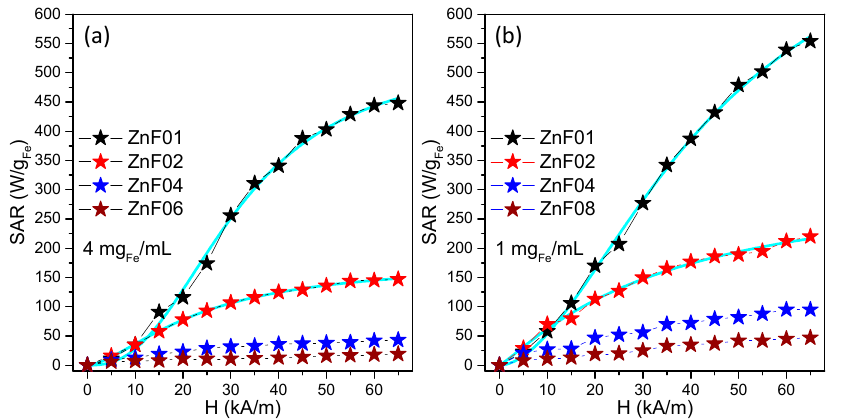
Figure 5. Specific absorption rate (SAR) dependence on the AMF amplitude (H) for ZnF particles dispersed in water at two different concentrations: ( a ) 4 mg Fe /mL and ( b ) 1 mg Fe /mL.